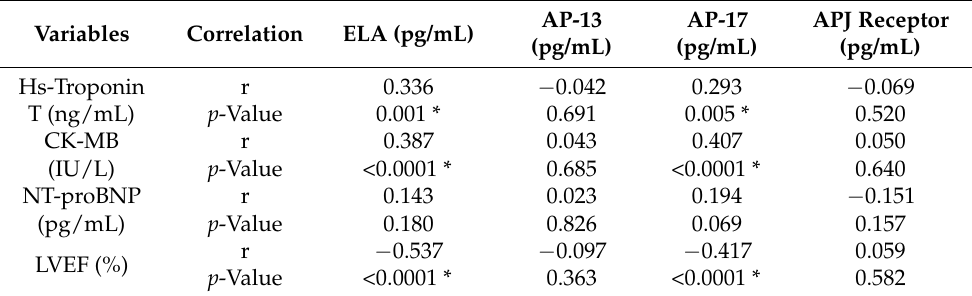
Table 4. Correlations between apelinergic system components and markers of myocardial infarction in total group of CAD